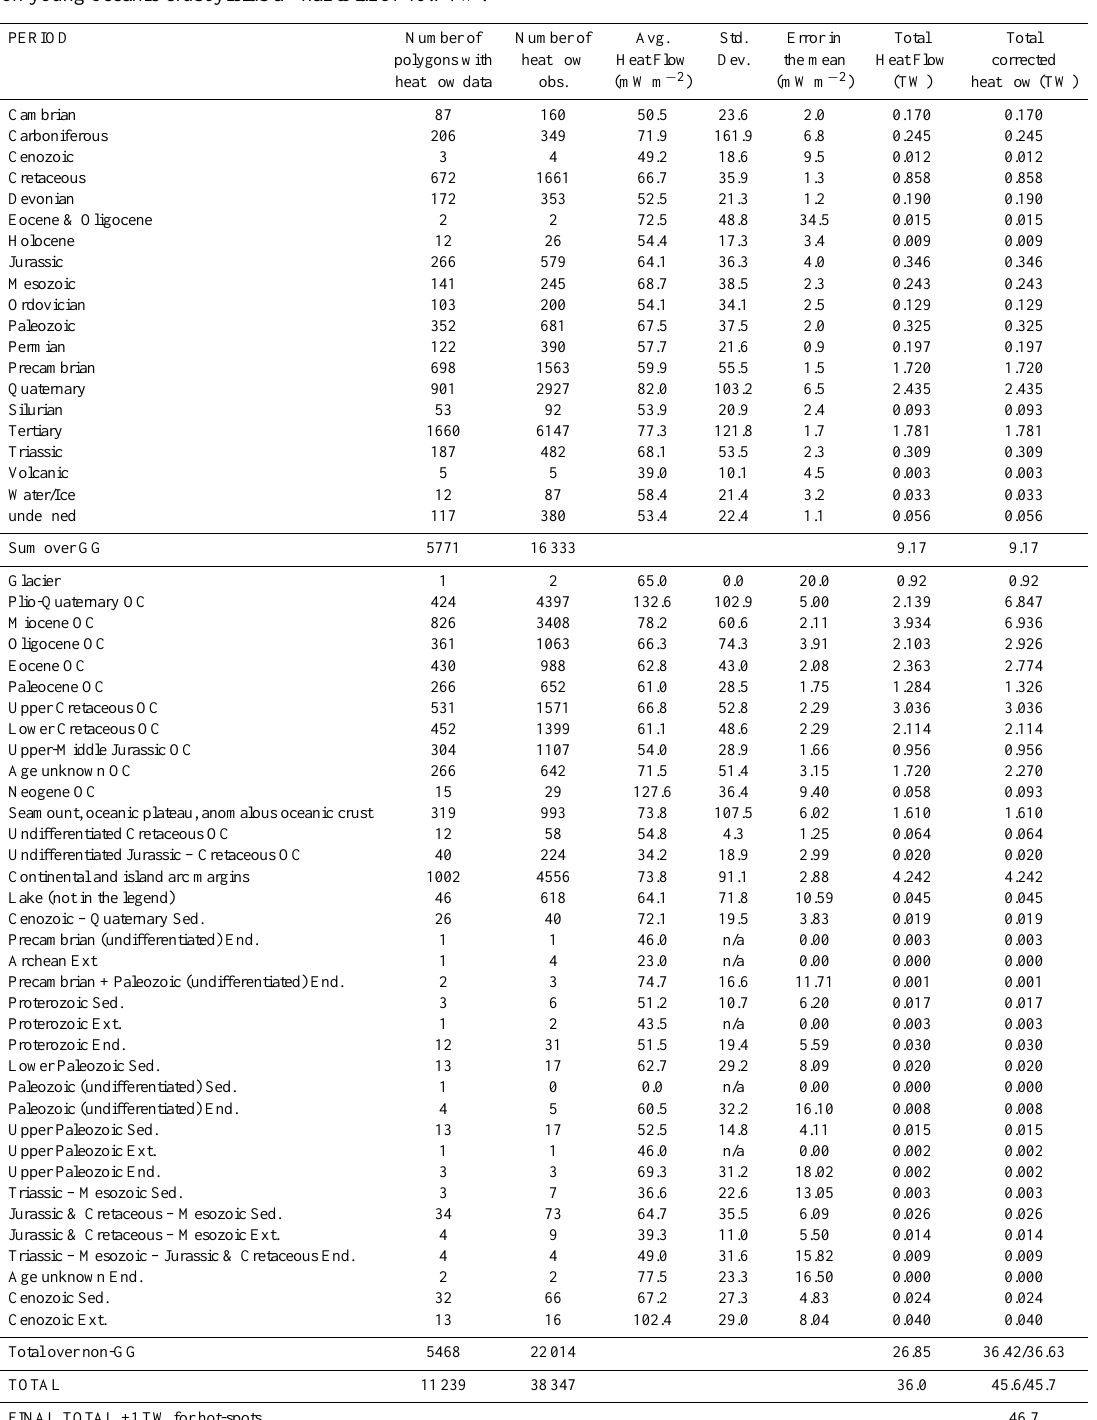
Table 3. Detailed breakdown of the preferred analysis for Earth’s surface heat flux. The raw data yields heat flow estimates of 105– 120mWm − 2 for the Glacier category (113.5mWm − 2 in the preferred analysis); the value of 65mWm − 2 listed here comes from Maule et al. (2005), with the error estimate based on the difference between 105 and 65mWm − 2 . The raw total, with no young ocean crust heat flow estimate, is 36.0TW. The total over the GG geology is 9.2TW. The total over the non-GG geology, including the young ocean estimate is 36.4TW, while 36.6TW is the value after allowance is made for ignoring geology classes with < 50 readings. Therefore, the final estimate, including the young ocean estimate, is 45.6TW (or 45.7TW, ignoring geology classes with < 50 readings). Adding 1TW for the effect of hot-spots on young oceanic crust yields a final total of